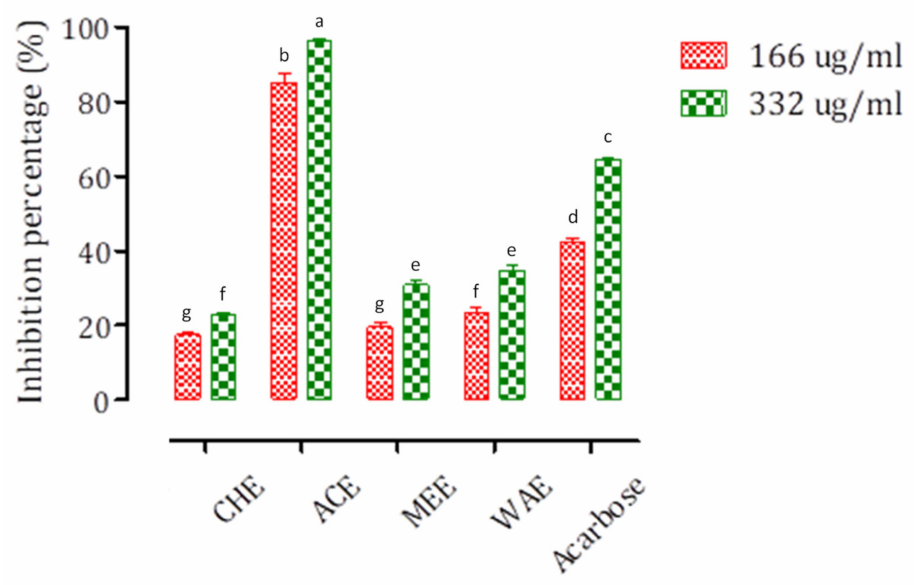
Figure 4. Inhibition of intestinal α -glucosidase by P. granatum bark extracts and Acarbose at two concentrations (166 and 332 µ g/mL). Different letters indicate significant differences at p <